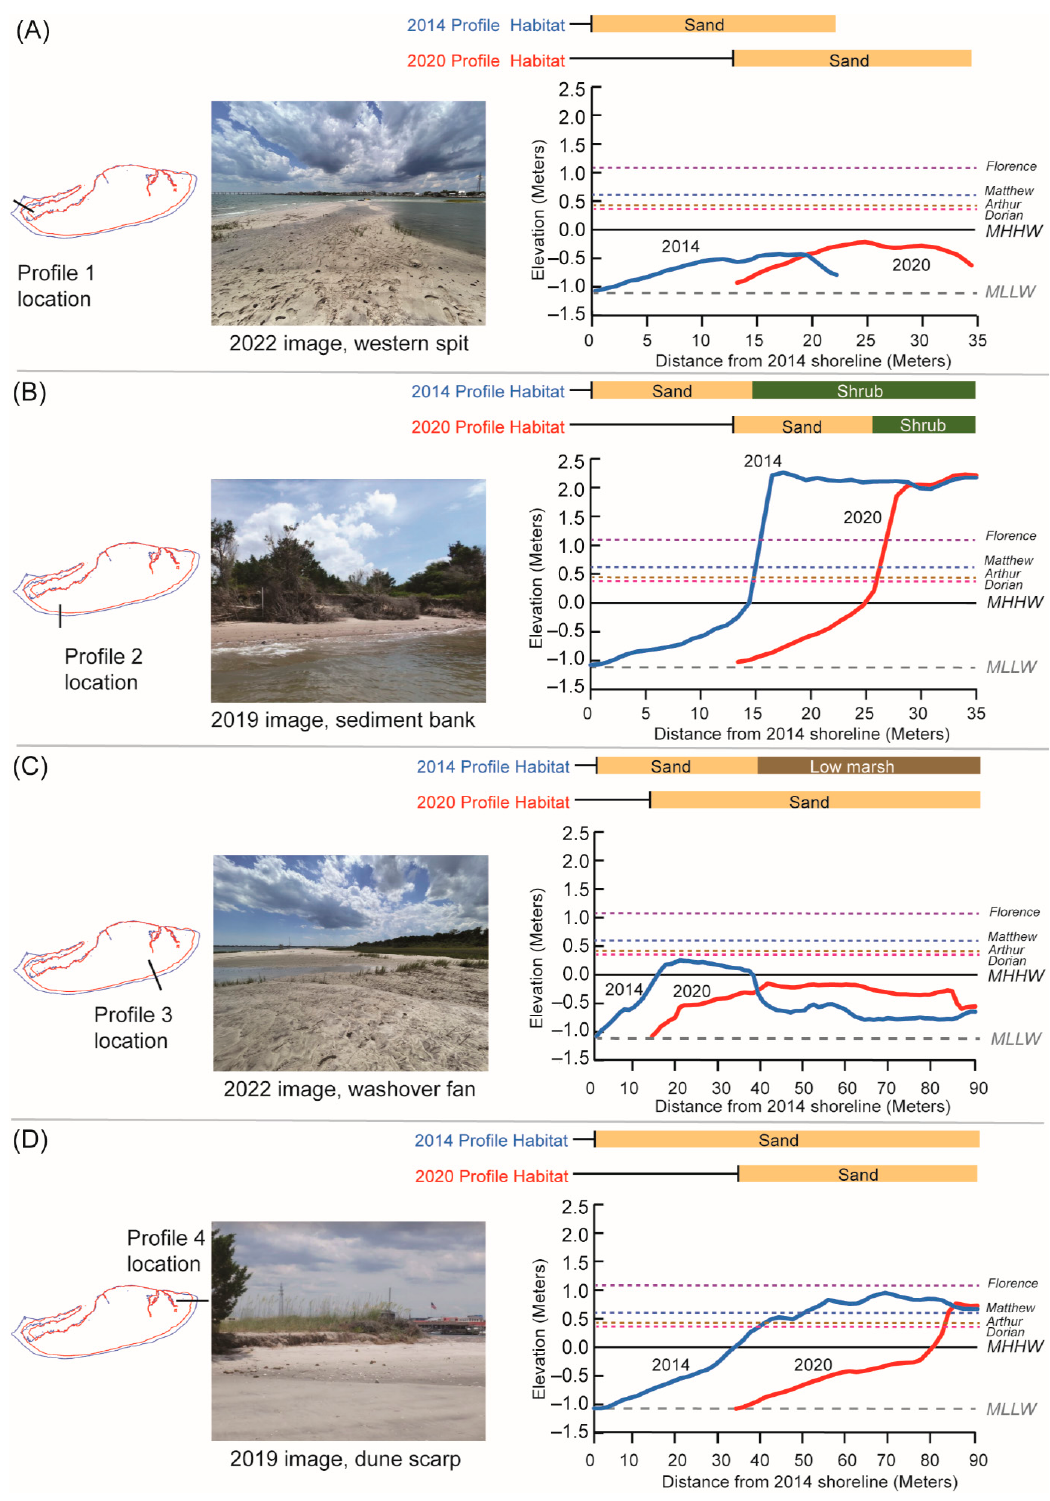
Figure 5. Morphology change is shown at selected profiles where the 2014 shoreline is blue and the 2020 shoreline is red. ( A ) Profile 1 of western spit, ( B ) Profile 2 of sediment bank, ( C ) Profile 3 of beach and foredune flattened into a washover fan, and ( D ) Profile 3 where waves cut back the dune, forming a scarp. The water levels for the four hurricanes are also shown to match the color of their tracks in Figure 1, as are 2019 images of sediment bank and dune scarp by Niels Lindquist and 2022 images of western spit and washover fan by Matthew